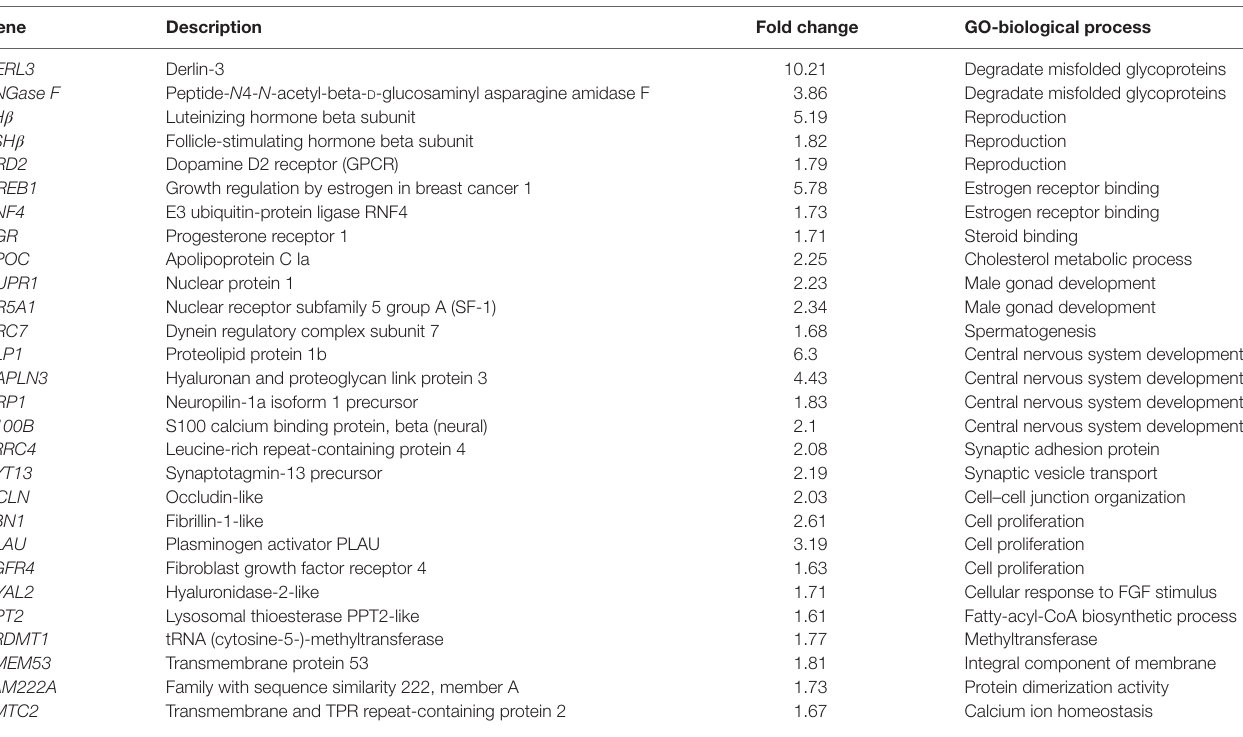
TaBle 1 | Genes upregulated by E2 in prepubertal grass carp pituitary cells. gene